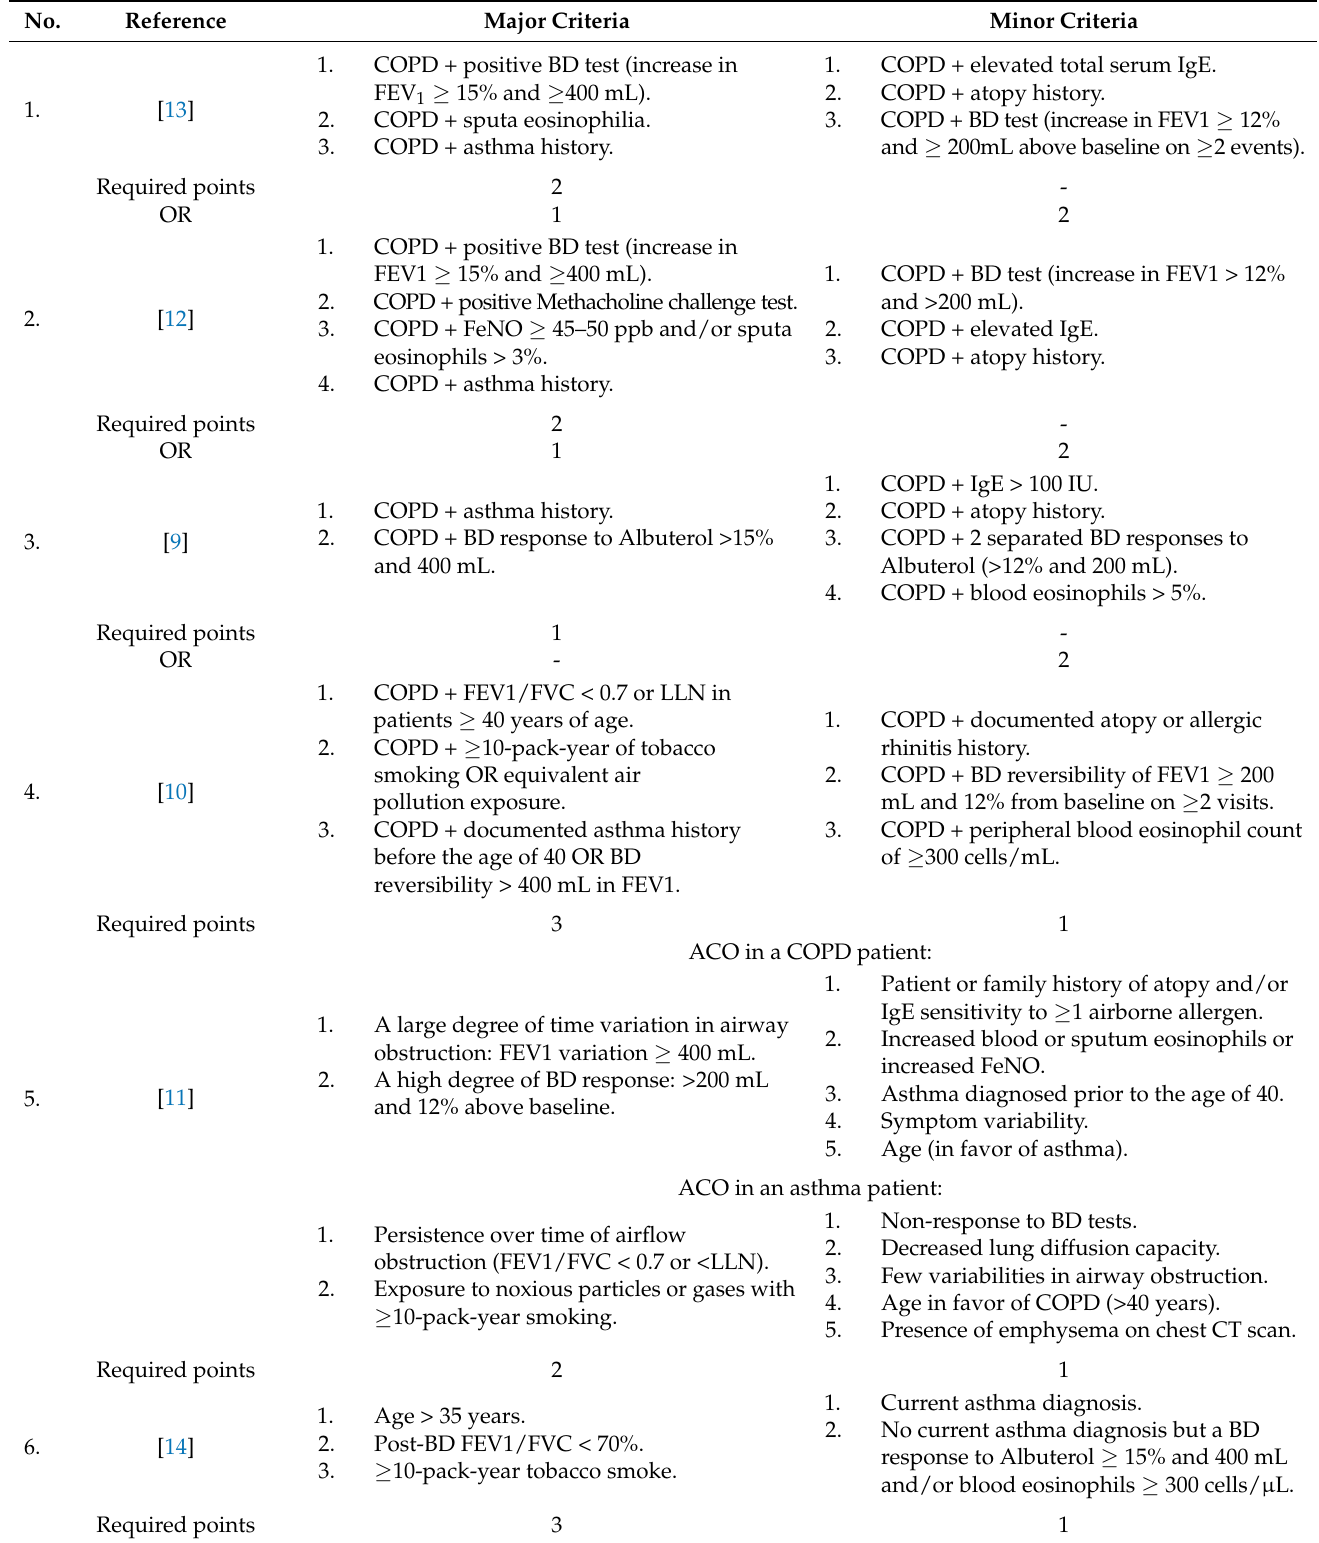
Table 2. Proposed ACO diagnostic criteria according to previous ten years’